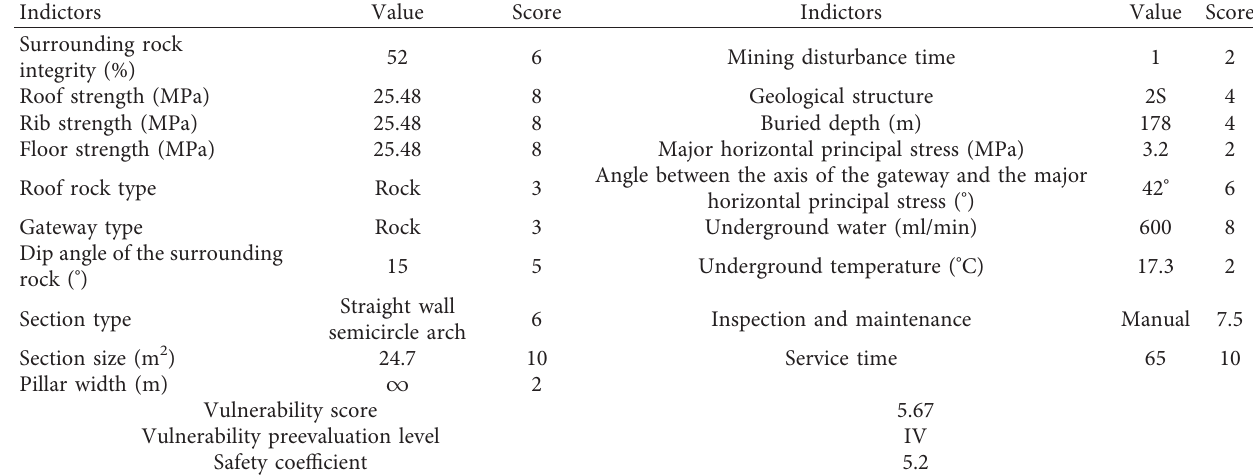
Table 22: Evaluation parameters and scores of the main inclined shaft.